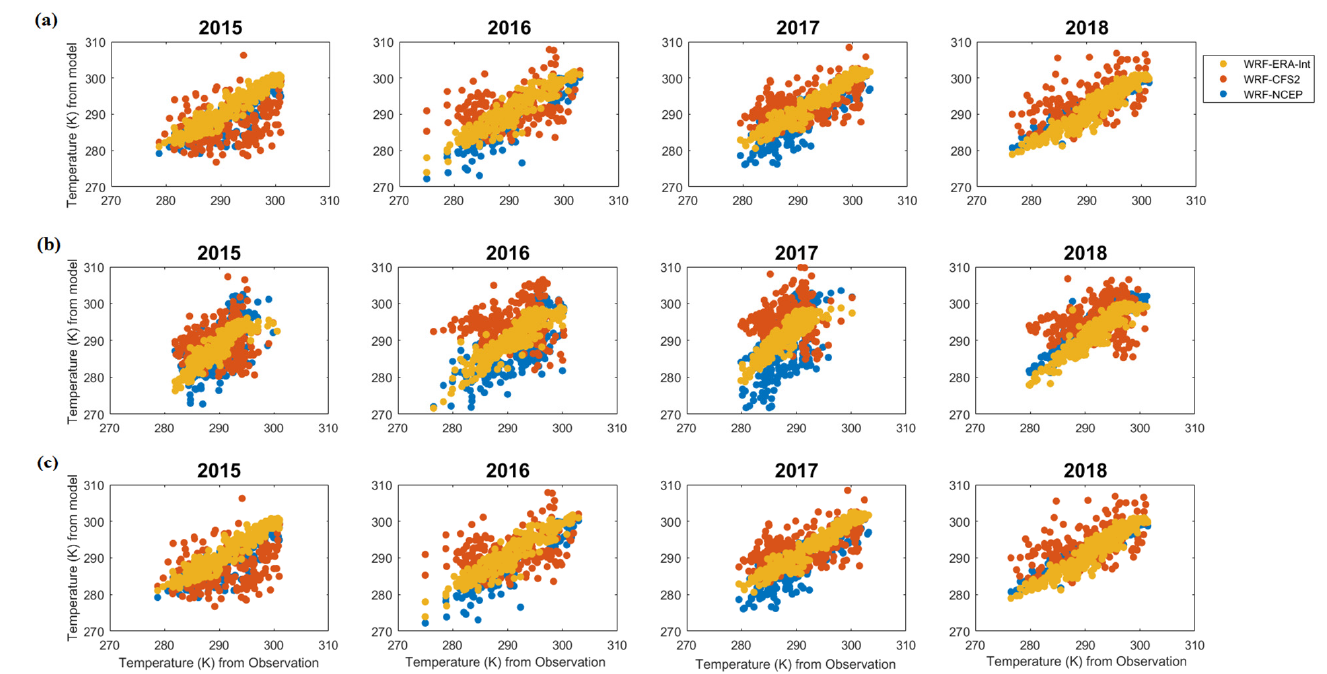
Figure A10. Daily average temperature in K from the models and observations at the onshore loca- tions ( a ) Shaoguan, ( b ) Nanping, and ( c ) Ganzhou.